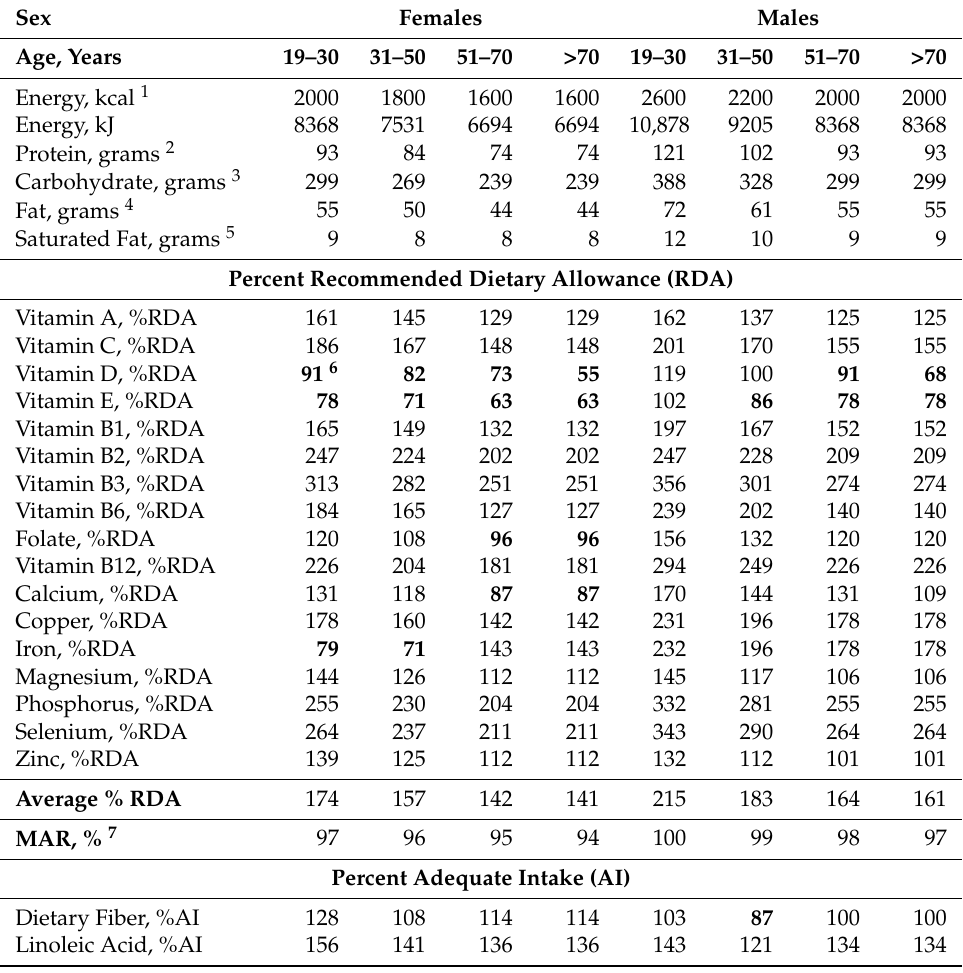
Table 4. Percent Recommended Dietary Allowance, Adequate Intake and Tolerable Upper Intake Levels of selected nutrients calculated for the average seven-day Swank low saturated fat menus without dietary